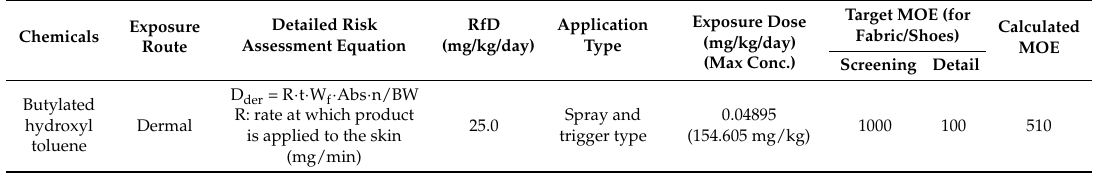
Table 8. Results of a dermal risk assessment for butylated hydroxyl